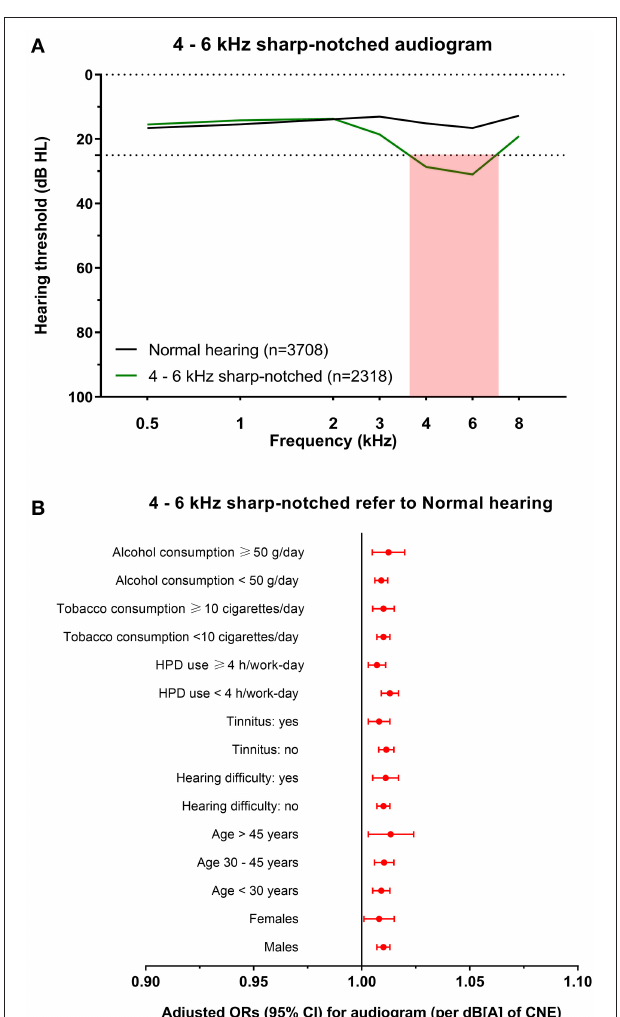
FIGURE 3 | The 4–6kHz sharp-notched audiogram and its association with noise exposure. (A) The average hearing thresholds over 0.5–8kHz frequencies of subjects with normal hearing and the cluster of 4–6kHz sharp-notched audiogram. The pink shade includes the range of notched frequencies. (B) Adjusted ORs with 95% CI of CNE increment (per dB[A]) for the 4–6kHz sharp-notched audiogram refer to normal hearing audiogram after stratification of sex, age, hearing difficulty, tinnitus, HPD use, tobacco consumption, and alcohol consumption.